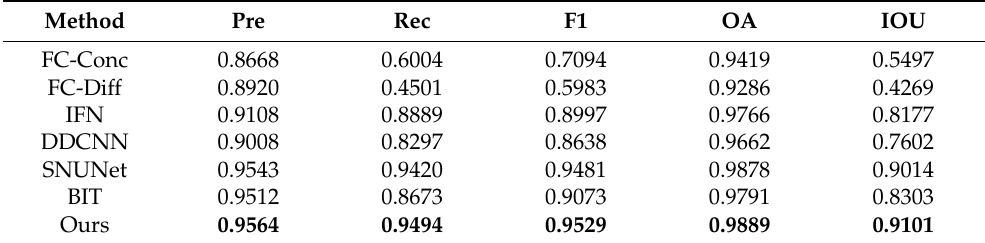
Table 3. The comparison results on the CDD dataset.